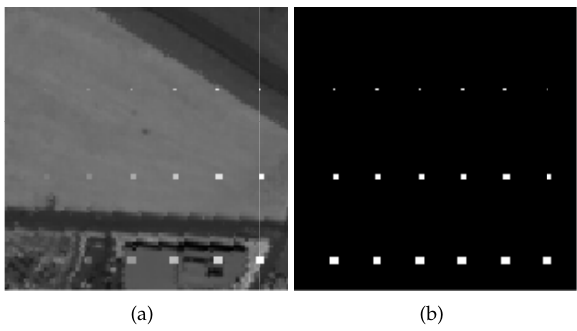
Figure 4. Synthetic Hyperspectral Dataset. ( a ) Synthetic dataset. ( b ) Ground truth of the synthetic dataset.